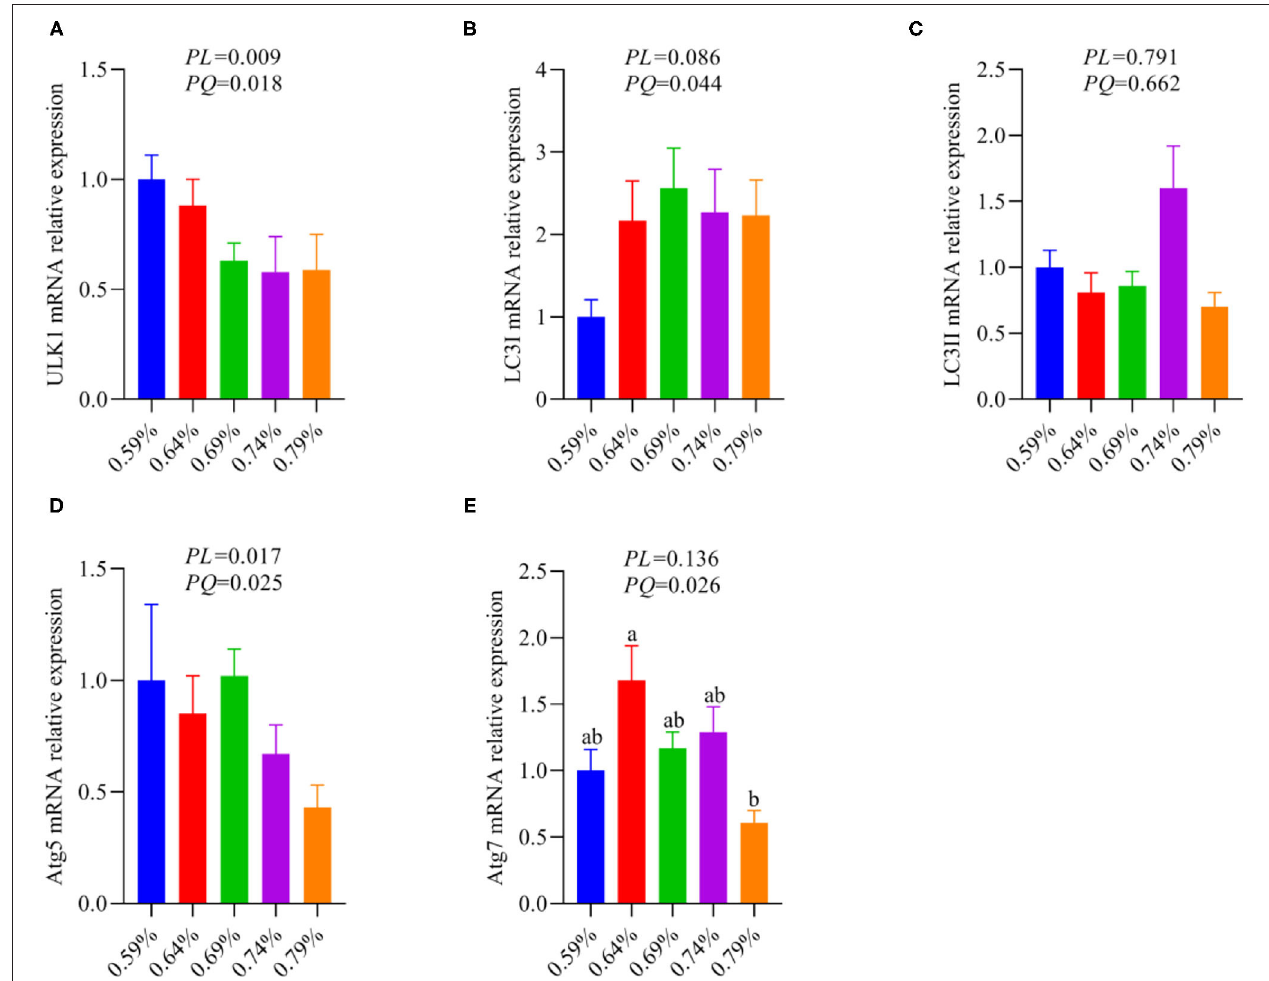
FIGURE 6 | The relative mRNA expression levels of an autophagy signaling pathway ( n = 6–8). (A) ULK1. (B) LC3I. (C) LC3II. (D) Atg5. (E) Atg7. a,b Means with different superscripts within a column differ significantly ( P <